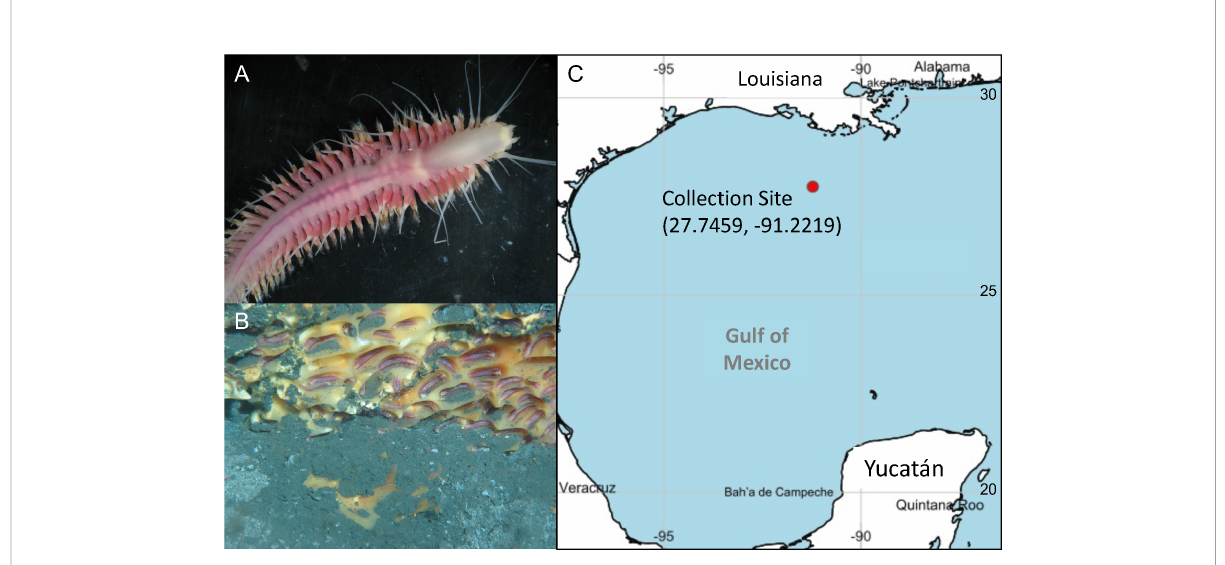
FIGURE 1 (A) Sirsoe methanicola individual viewed under a compound microscope (photo credit: R. Emlet/C. Young aboard R/V Seward Johnson ; (B) S. methanicola individuals colonizing depressions on a methane hydrate (photo credit: SJ-2009-GOM-JSL2-3751-014, Johnson Sea Link II, Harbor Branch Oceanographic Institute); (C) Map showing location of the sampling site (generated from https://www.simplemappr.net. Accessed December 15,